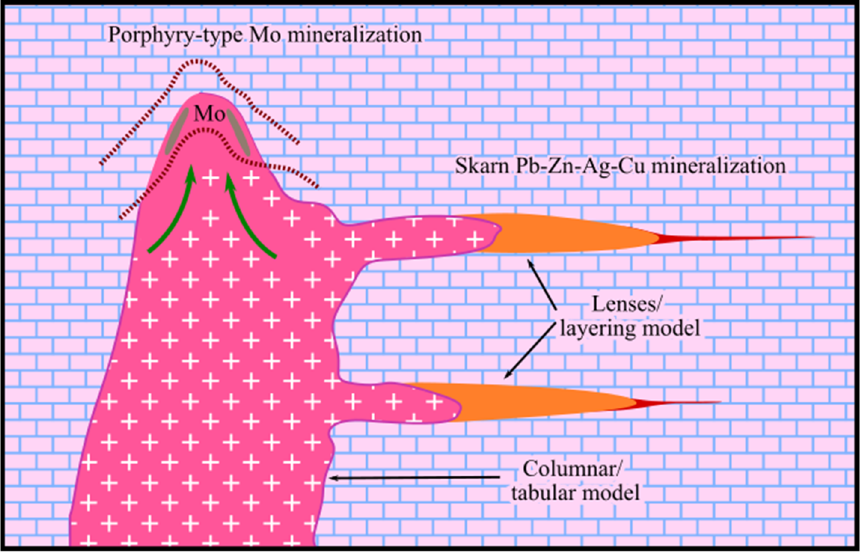
Figure 9. The typical model of porphyritic and skarn mineralization (modified from [11]).